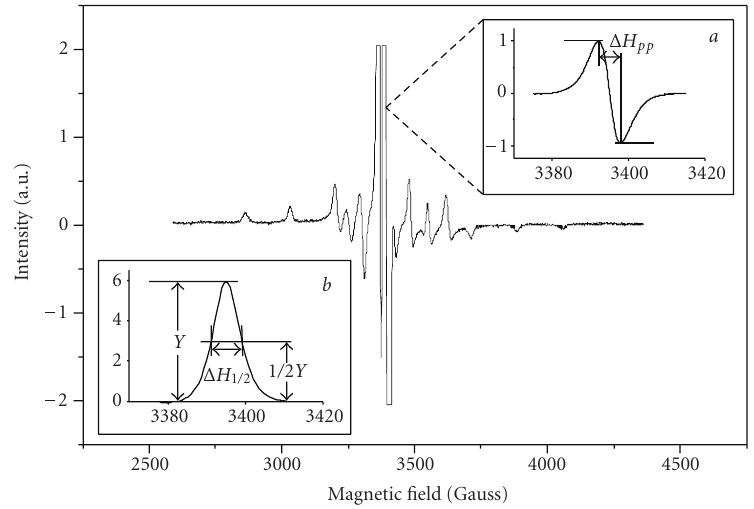
Figure 1: EPR spectrum of Arabian light crude oil at room temperature (gain = 1 . 0 × 10 4 ). (a) EPR spectrum of the free radical (gain = 2 . 0 × 10 3 ). Δ H pp is peak-to-peak linewidth. (b) EPR line integration of the free radical. Δ H 1 / 2 is linewidth at